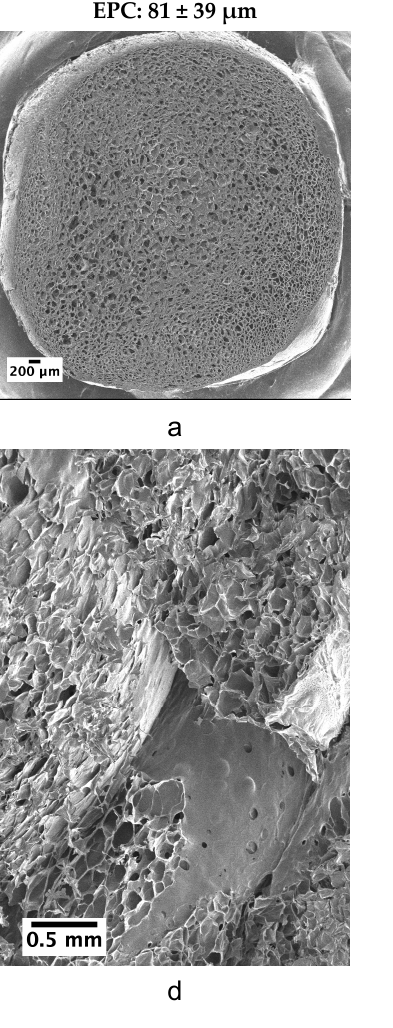
Figure 2. SEM pictures of the foamed beads of ( a ) expanded PC (EPC), expanded PP ( b ) (EPP), and expanded PET ( c ) (EPET) and corresponding parts EPC ( d ), EPP ( e ) and EPET ( f ) at 200 kg / m 3